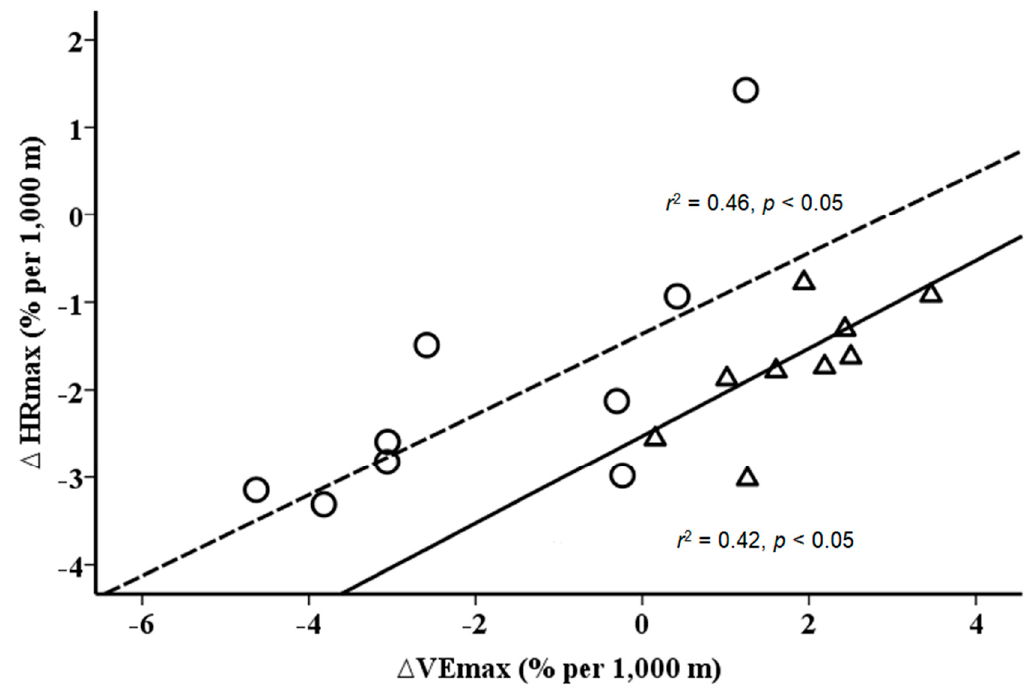
Figure 4. Relationship between changes (%) in maximal minute ventilation (VE max ) and maximal heart rates (HR max ) per 1 km gain in altitude. Solid line (triangles) for hypobaric hypoxia ( r 2 = 0.46, p < 0.05) and dashed line (circles) for normobaric hypoxia ( r 2 = 0.42, p < 0.05). Delta values are calculated as HH/NH values minus sea level values.